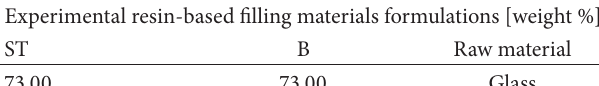
Table 2: Formulations of experimental resin-based restorative materials (ST = standard).